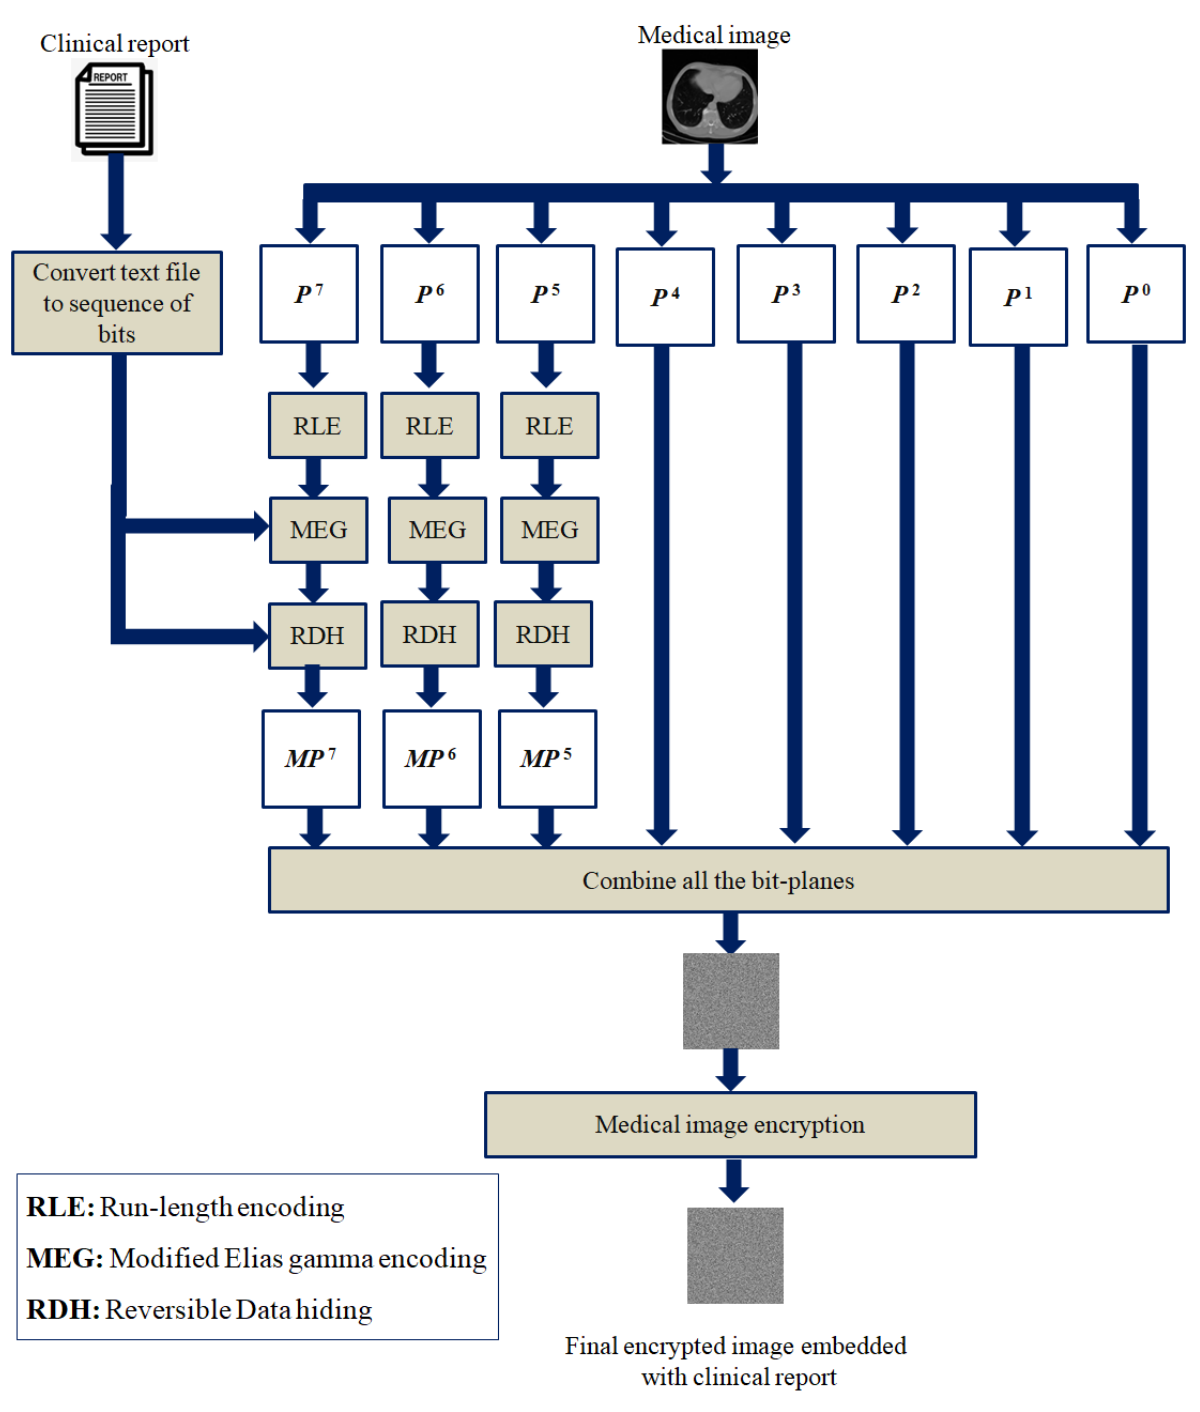
Figure 4. Illustrative diagram of the proposed